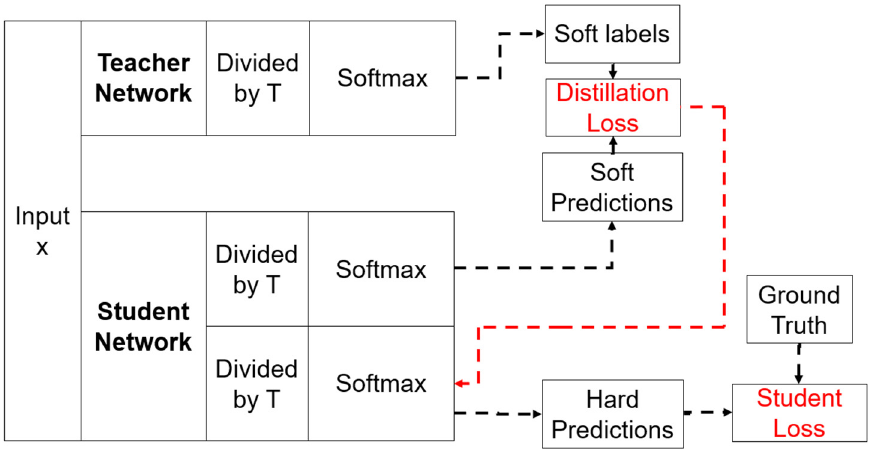
Figure 1. The knowledge distillation architecture.